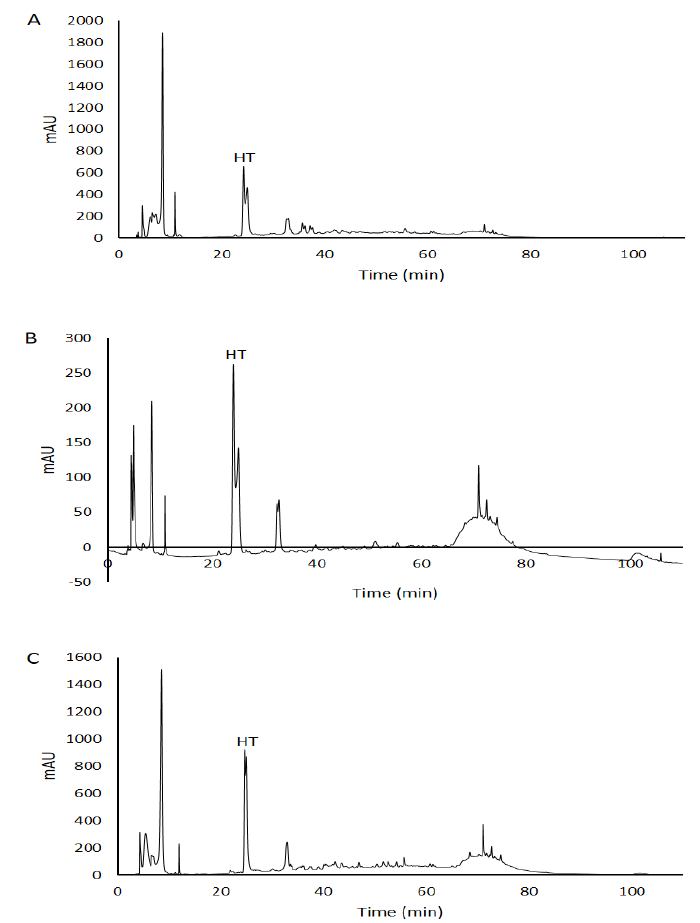
Figure 1. Chromatographic profile of OOD extracts from Basso ( A ), Dell’Orto ( B ), and EVO ( C ) oil mills. OOD were extracted according to Method 1–acidified methanol, as described in Section 2.3. HT: hydroxytyrosol. Table 1. Extraction yields (Method 1–acidified methanol).